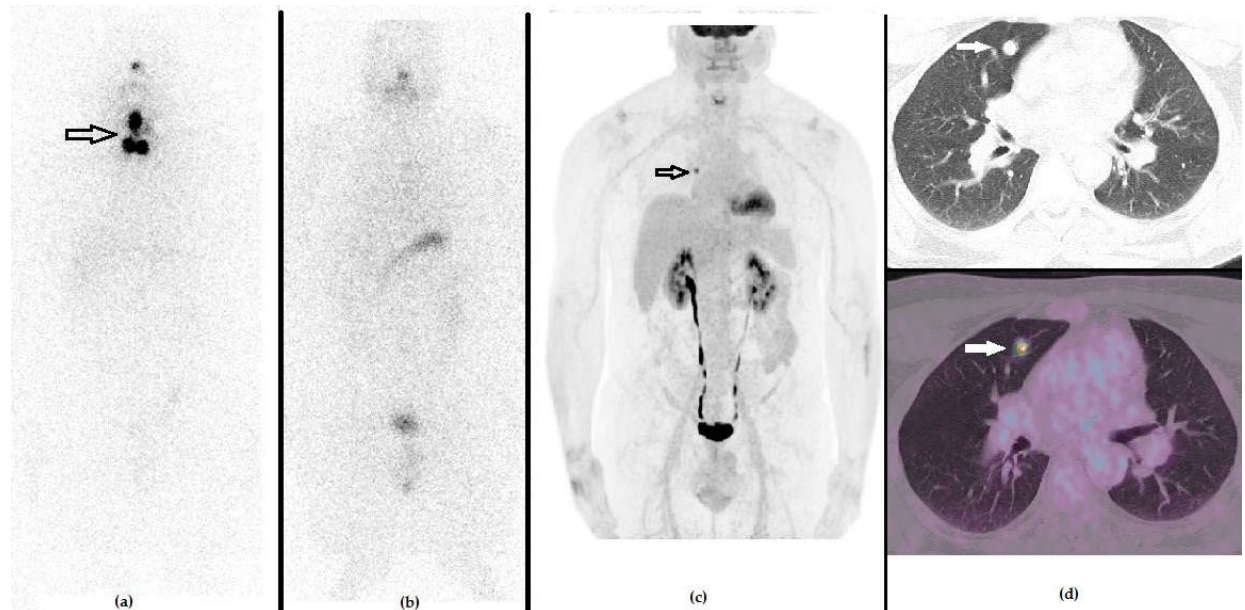
Figure 4. A 49-year-old male that previously underwent a thyroidectomy plus CND and 1 cycle of RAI due to PTC (pT3a N0 R0). The first panel represents the post-RAI 131 I-WBS, showing the residual iodine-avid tissue in the anterior cervical region. ( a ) One year after RAI, he presented with an increased value of stimulated Tg serum level (i.e., 89 ng/mL), in spite of negative 131 I-WBS ( b ) and no morphological signs of relapse at neck US or CXR. PET/CT with 18 F-FDG demonstrated a focus of increased tracer uptake in the right lung, as evident by whole body ( c ) and axial CT ( d , upper raw) and fused PET/CT (( d ), lower raw) slices. The patient underwent surgery and histology was positive for PTC lung metastasis.